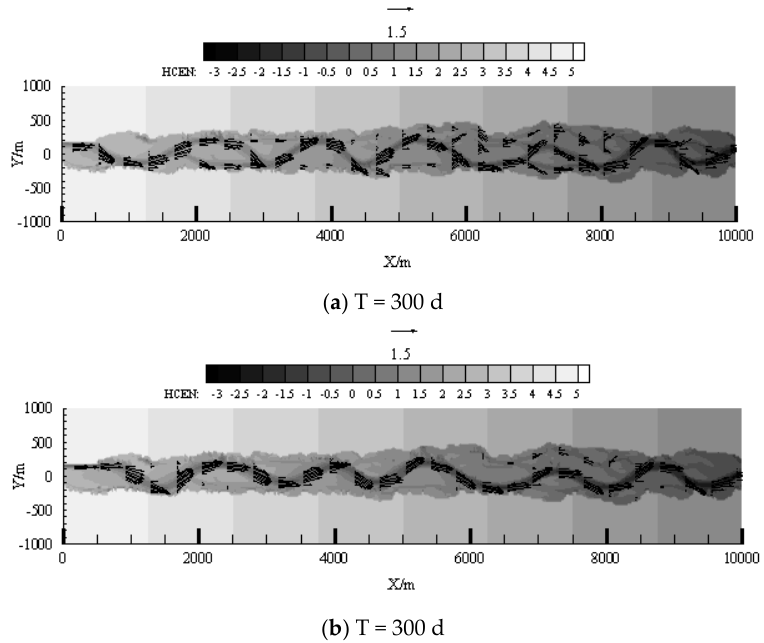
Figure 10. Temporal changes in flow field including velocity and bed elevation of Run No. 4. ( a ) T = 300 d and ( b ) T = 300 d.